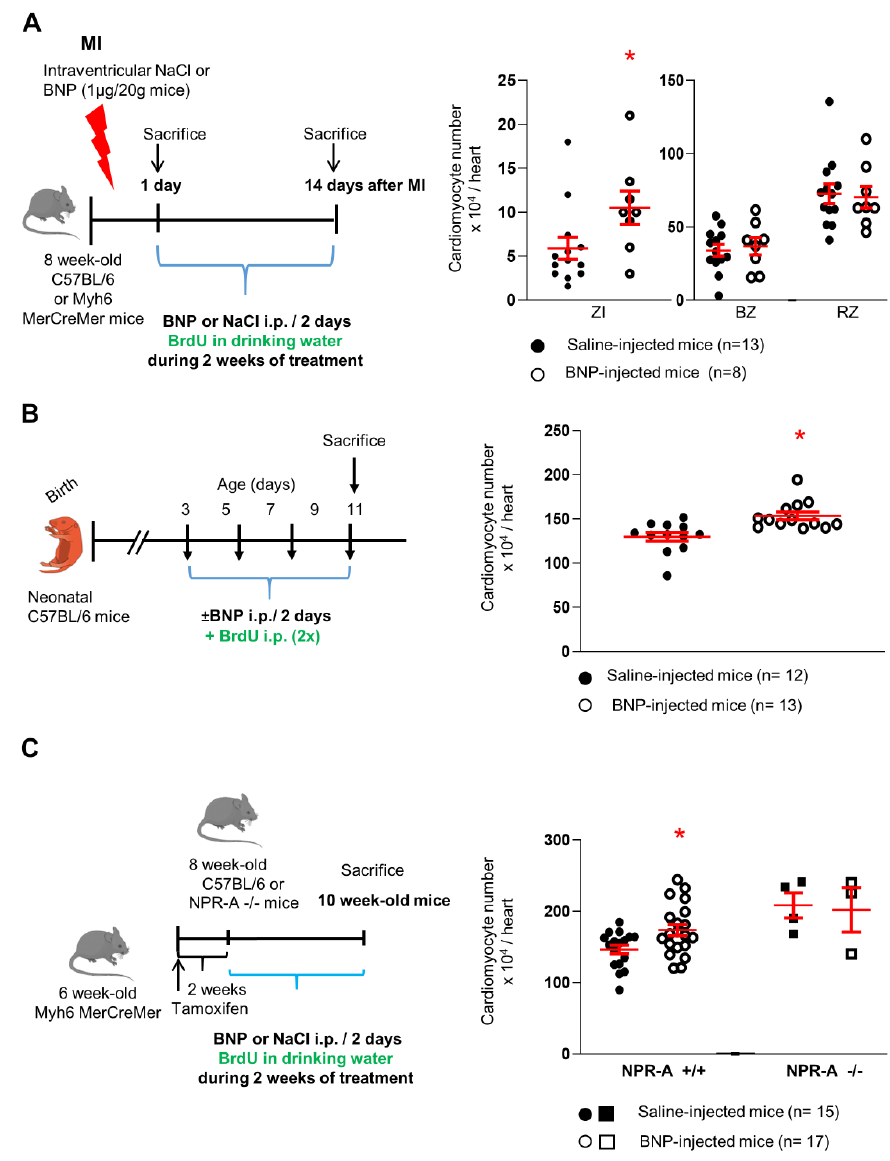
Figure 1. BNP treatment leads to increased number of cardiomyocytes. BNP injections in infarcted mice ( A ), neonatal ( B ) and adult ( C ) unmanipulated mice (experimental protocol as described in detail in Material and Methods section). For each experimental model, individual values (i.e., the total number of CMs in one heart) represented and the means ± SEM depicted in red. CMs isolated also from unmanipulated adult hearts deficient in NPR-A receptor (NPR-A − / − ) and treated with saline (n = 4) or BNP (n = 3). ZI: infarct zone, BZ: border zone, RZ: remote zone. * p < 0.05.